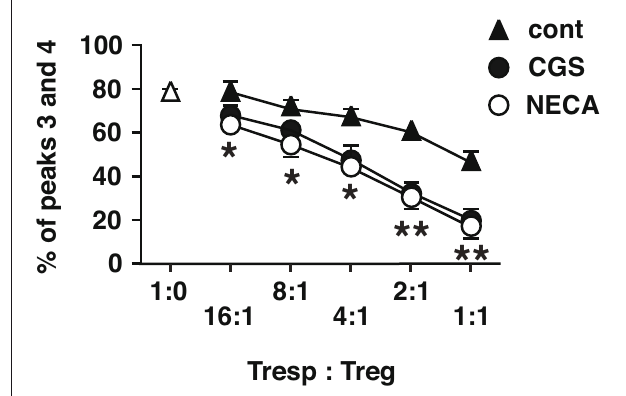
FIGURE 5 | Statistically significant enhancement of T cell inhibitory activity of Treg cultured with A2AR agonists. The data of CFSE assay was presented as proportion of cells which entered into extensive proliferation. Numbers represent combined percentages of peaks 3 and 4 in Figure 4 . Data represent average ± SD of three separate experiments. ∗ P < 0 . 01; ∗∗ P < 0 . 001 for both control vs. CGS and control vs. NECA.